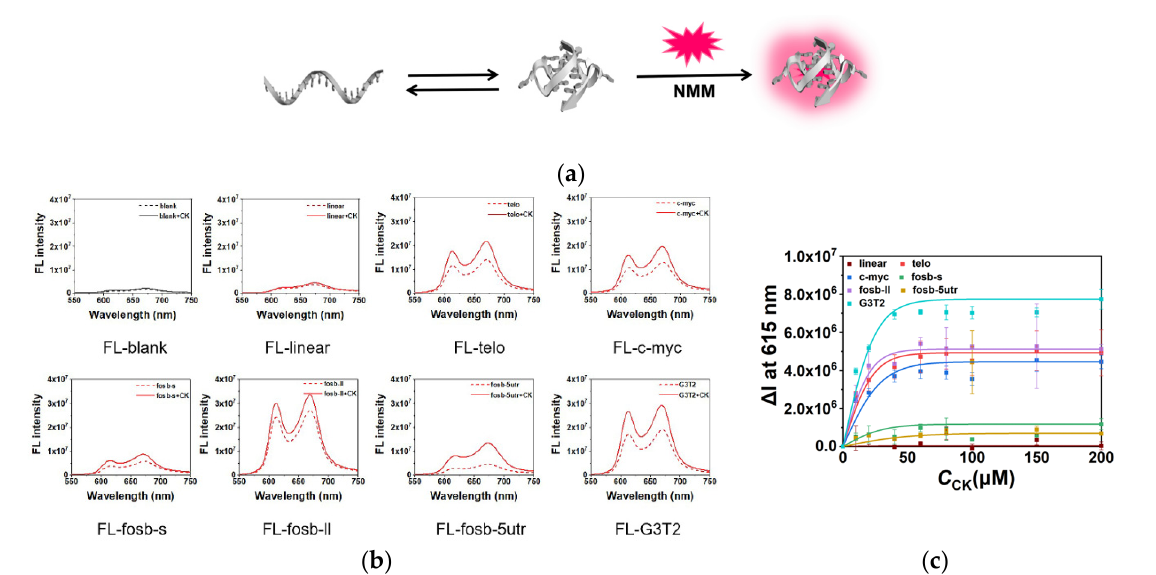
Figure 2. ( a ) The schematic demonstration of the equilibrium of coil DNA and G4 in the presence of fluorescence probe NMM. ( b ) The fluorescence spectra of NMM with different sequences in the absence (dash lines) and presence (solid lines) of 100 μ M CK. ( c ) The fluorescence intensity changes ( Δ I) at 615 nm in the presence of different concentrations of CK in the buffer containing 40 mM Tris-HCl (pH 7.6), 8 mM MgCl 2 , and 10 mM KCl.